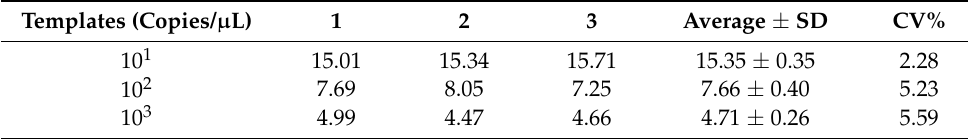
Figure 5. Repeatability analysis of the real-time RT-RAA assay. The real-time RT-RAA assay was repeated three times with 10 3 copies/ µ L, 10 2 copies/ µ L, and 10 1 copies/ µ L. Table 3. Data from the repeatability analysis of the real-time RT-RAA